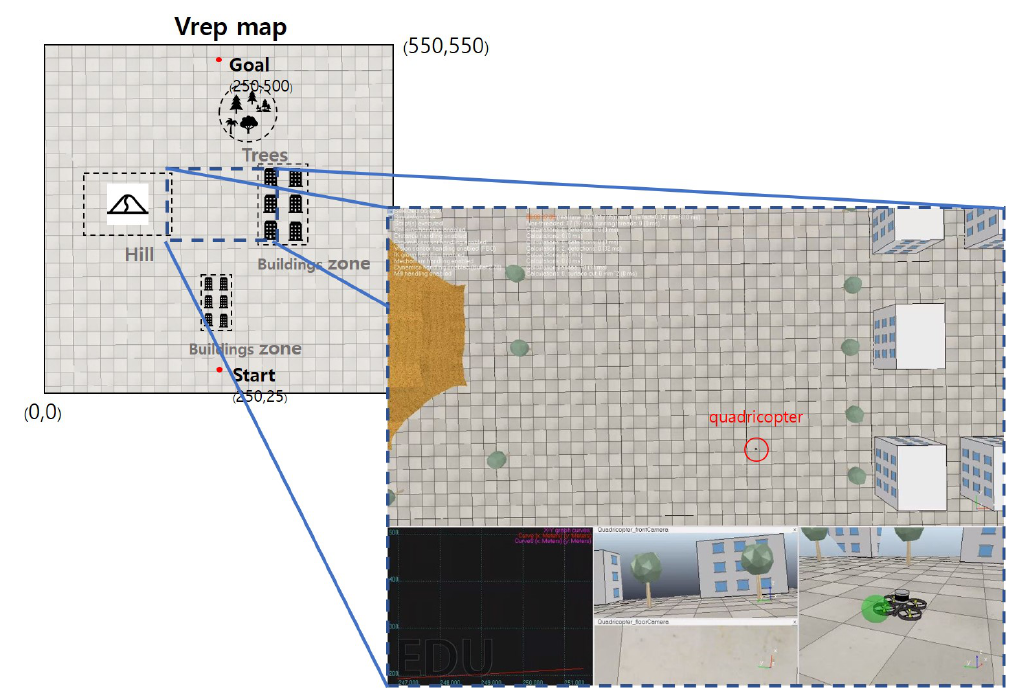
Figure 12. Realistic Experimental